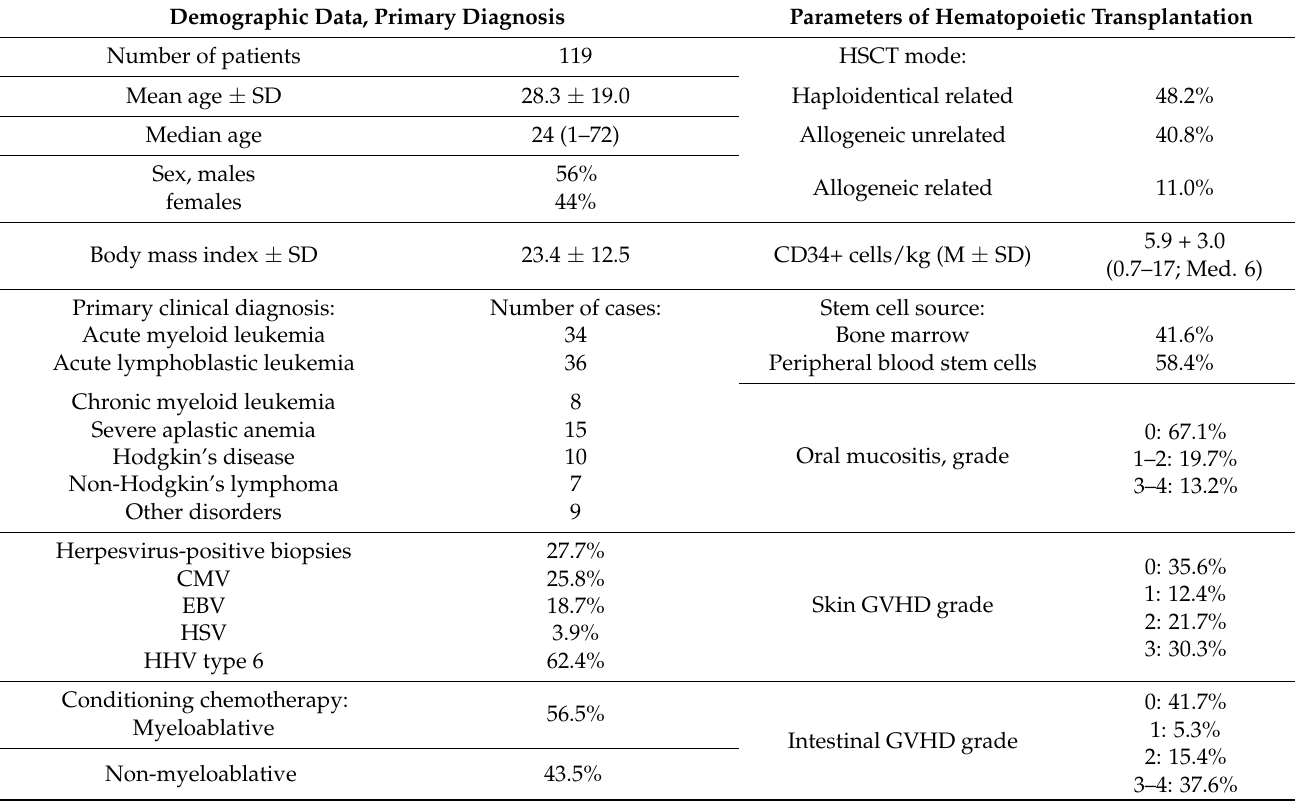
Table 1. Clinical characteristics and HSCT parameters of post-transplant patients with intestinal